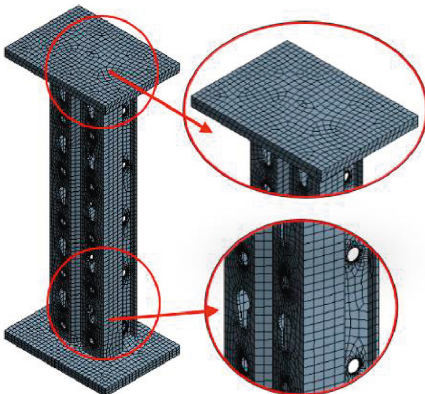
Figure 8: Mesh of the FE model on stub